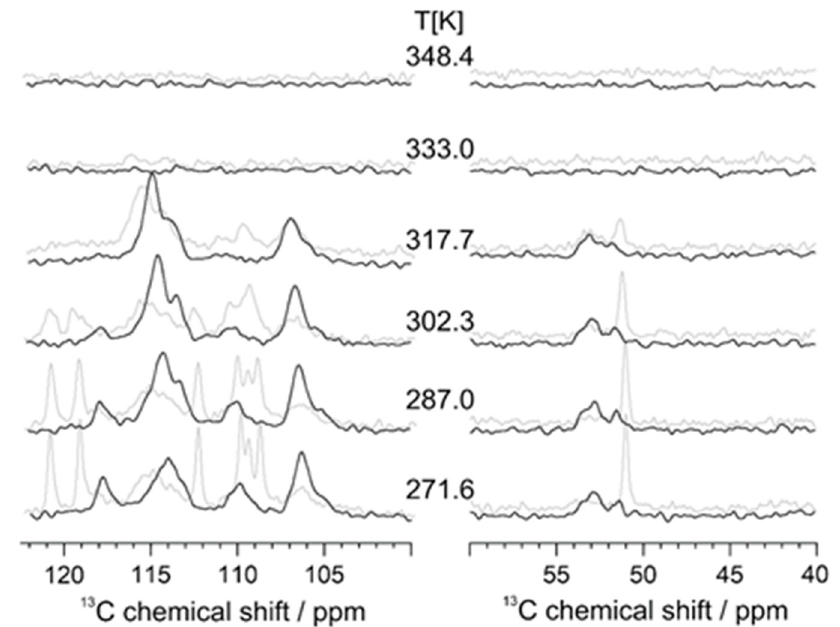
Figure 15. Zoomed 13 C CP-MAS NMR spectra of thermally treated (black line) and native (grey line) PAZE100 at variable temperature of the outer phenyl rings, inner phenyl ring ( a ) and polymer main chain ( b ).